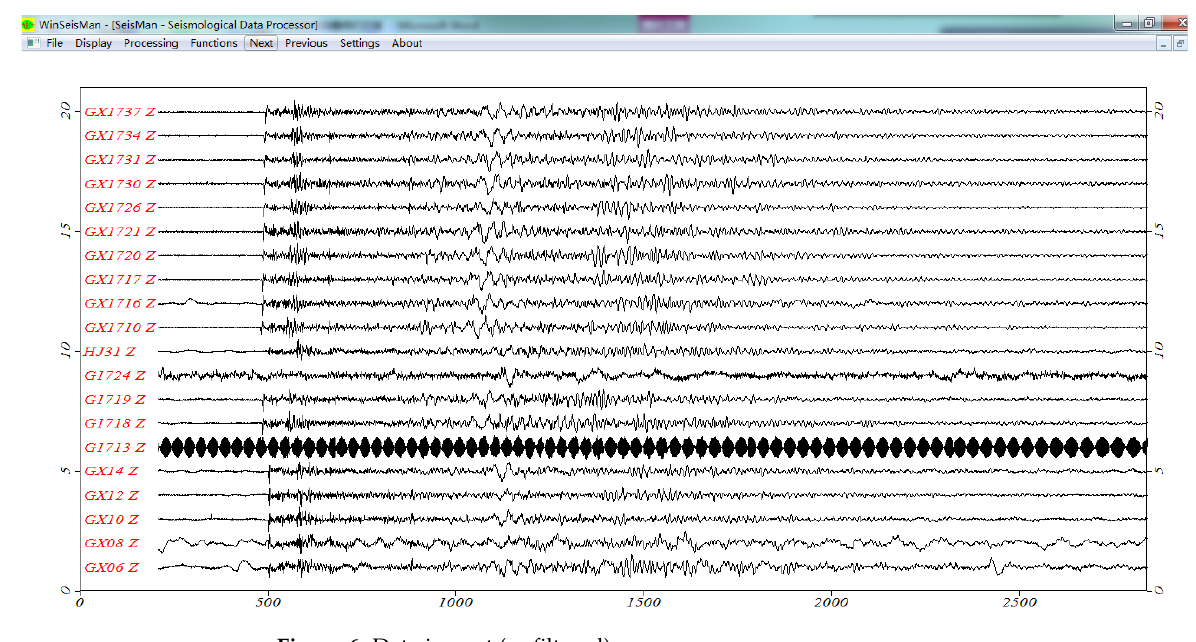
Figure 6. Data import (unfiltered).